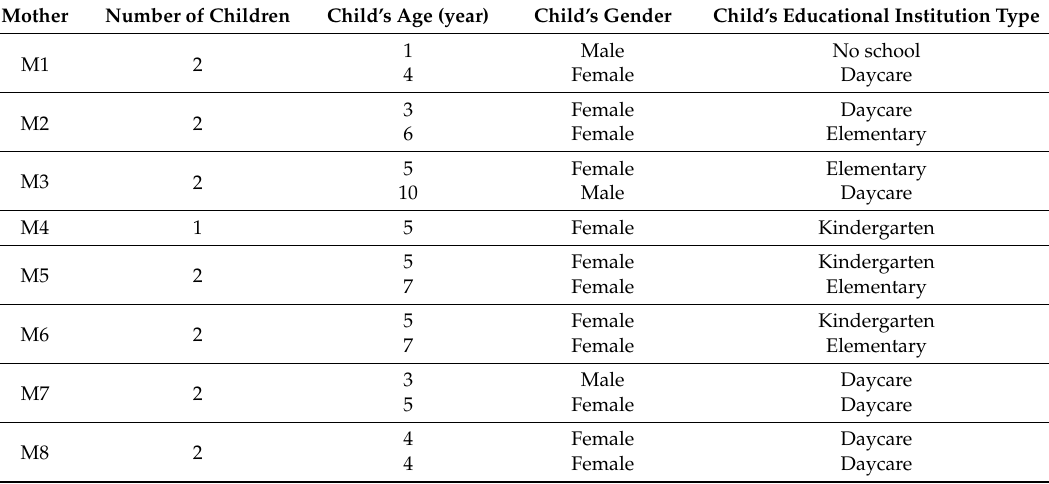
Table 1. Information of participants and their